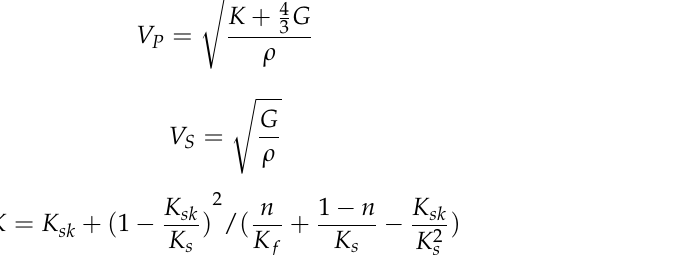
where K sk is the effective bulk modulus of the soil skeleton, K s is the bulk modulus of solid grains, K f is the bulk modulus of the pore fluid, and n is porosity. K sk is determined by measuring the V s and V p values of dry soil. For a given value of S r , K f can be determined using Equation (8):